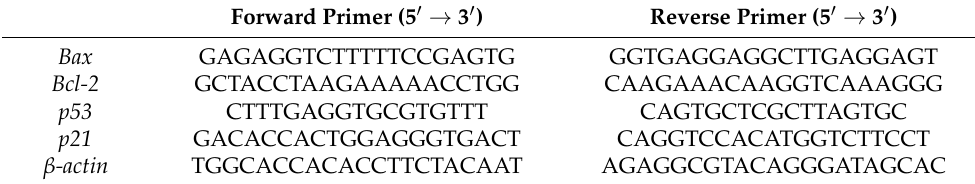
Table 2. Information of qRT-PCR